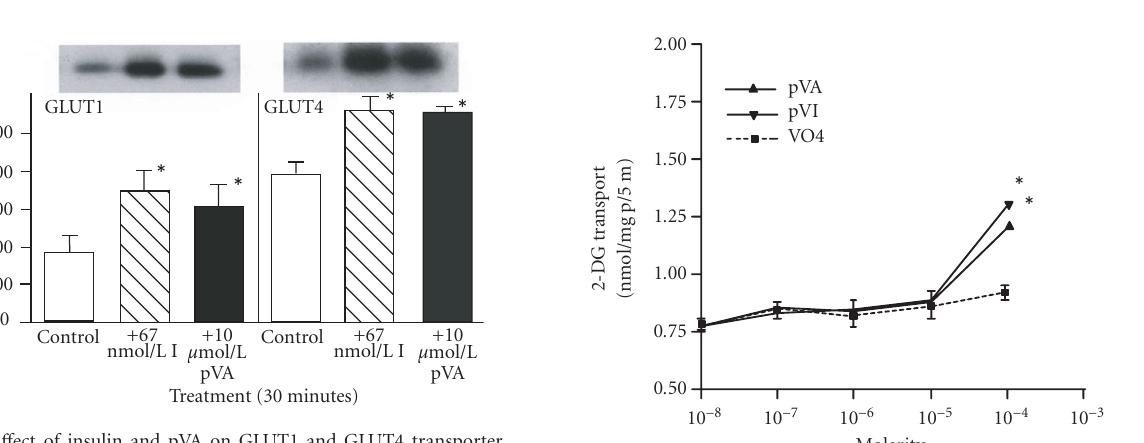
Figure 4. E ff ect of insulin and pVA on GLUT1 and GLUT4 transporter translocation in 3T3-L1 adipocytes. The GLUT1 and 4 transporters content are expressed in crude plasma membrane preparations in control, insulin- treated (ie, 67nmol/L I) and pVA treated (ie, 10 − 5 mol/L pVA) membranes. GLUT1: ∗ P < . 05;1-way ANOVA, F = 6 . 8, GLUT4: ∗ P < . 05, 1-wayANOVA, F = 7 . 7, n = 3. All data ± SE.